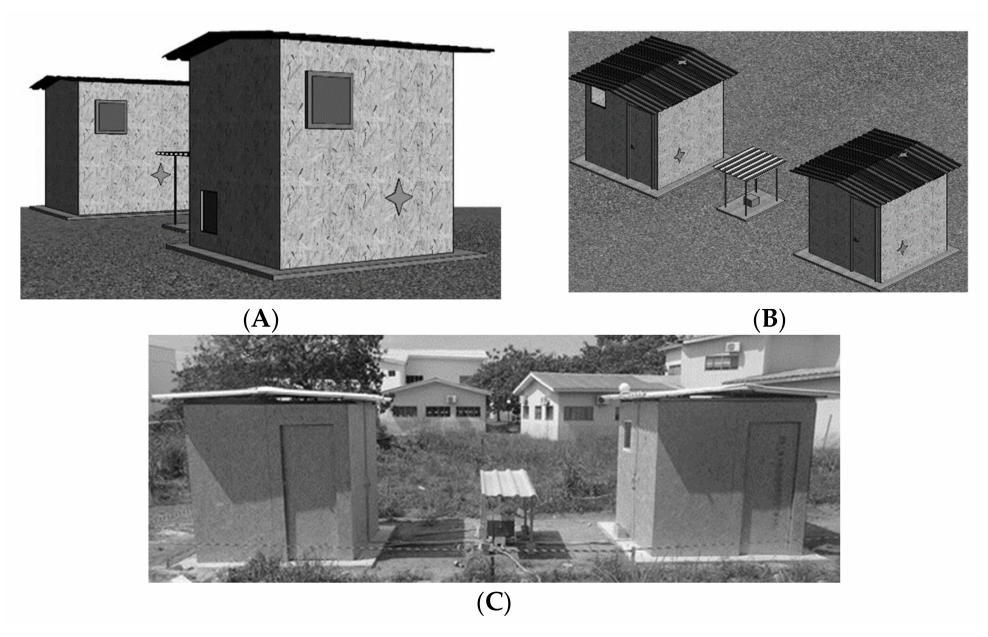
Figure 3. Test cells: ( A , B ) Layout of the two test cells; ( C ) Photograph of the